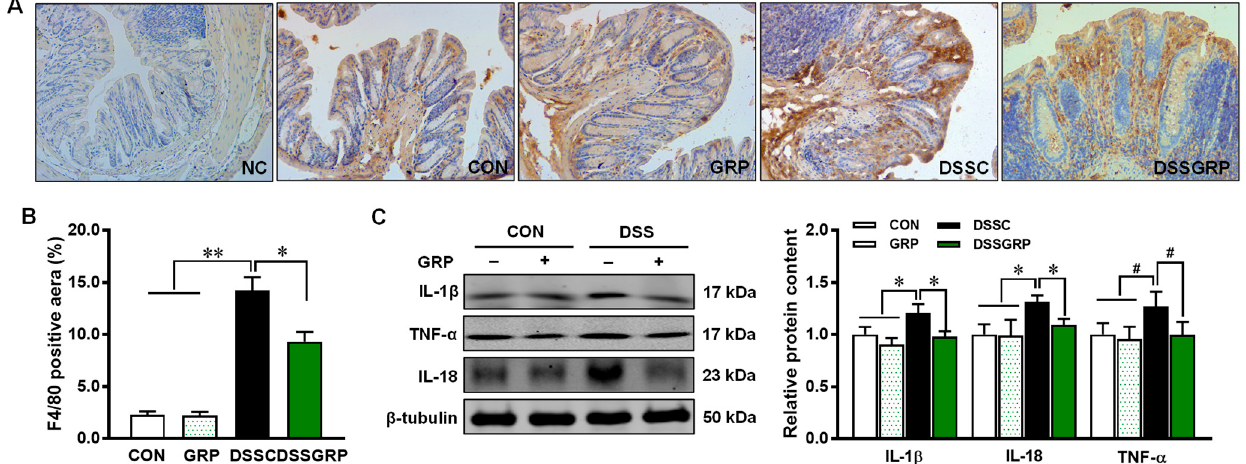
Figure 3. GRP supplementation inhibits macrophage infiltration and suppresses inflammation in the colonic tissues of mice with DSS-induced colitis. ( A ) Representative images of F4/80 staining. ( B ) The statistics of F4/80 staining. ( C ) Relative protein contents of IL-1 β , TNF- α , and IL18. NC: Negative control, CON: Control, GRP: Sulforaphane glucosinolate, DSSC: DSS-treated control mice, DSSGRP: DSS-treated mice with GRP supplementation. n = 8–9 mice per group. # p < 0.10, * p ≤ 0.05, ** p ≤ 0.01.